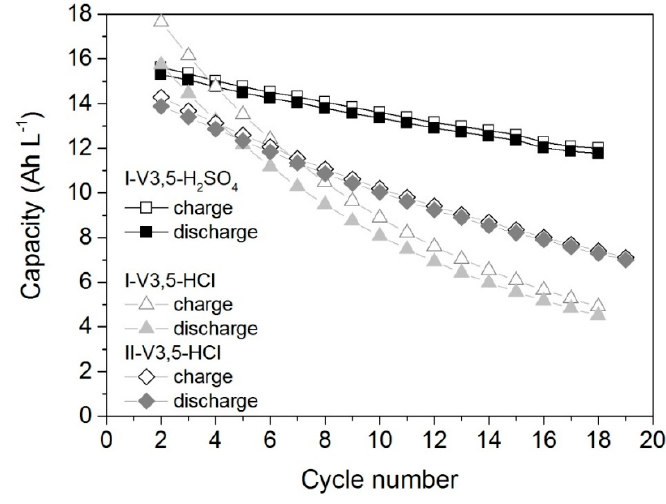
Figure 4. Cyclability of the cell operated with I-V3.5-H 2 SO 4 , I-V3.5-HCl, and II-V3.5-HCl